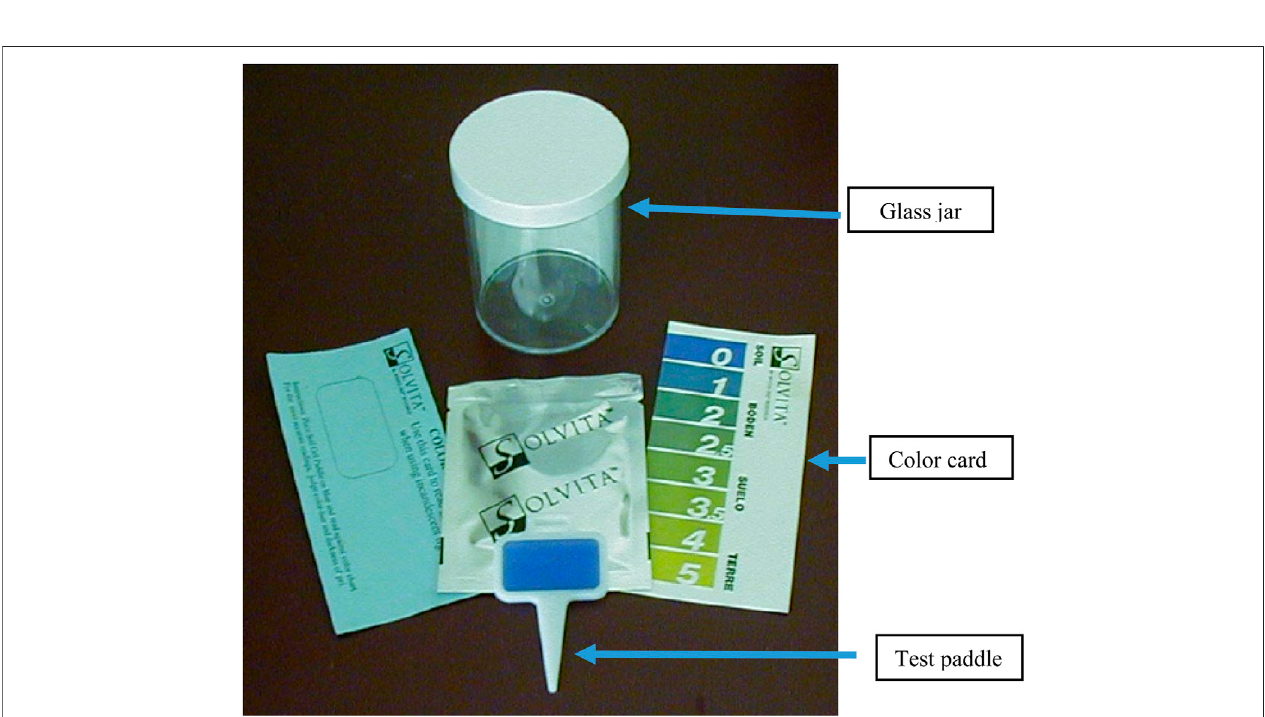
FIGURE 2 | Solvita ® test kit used to measure CO 2 evolution over time.